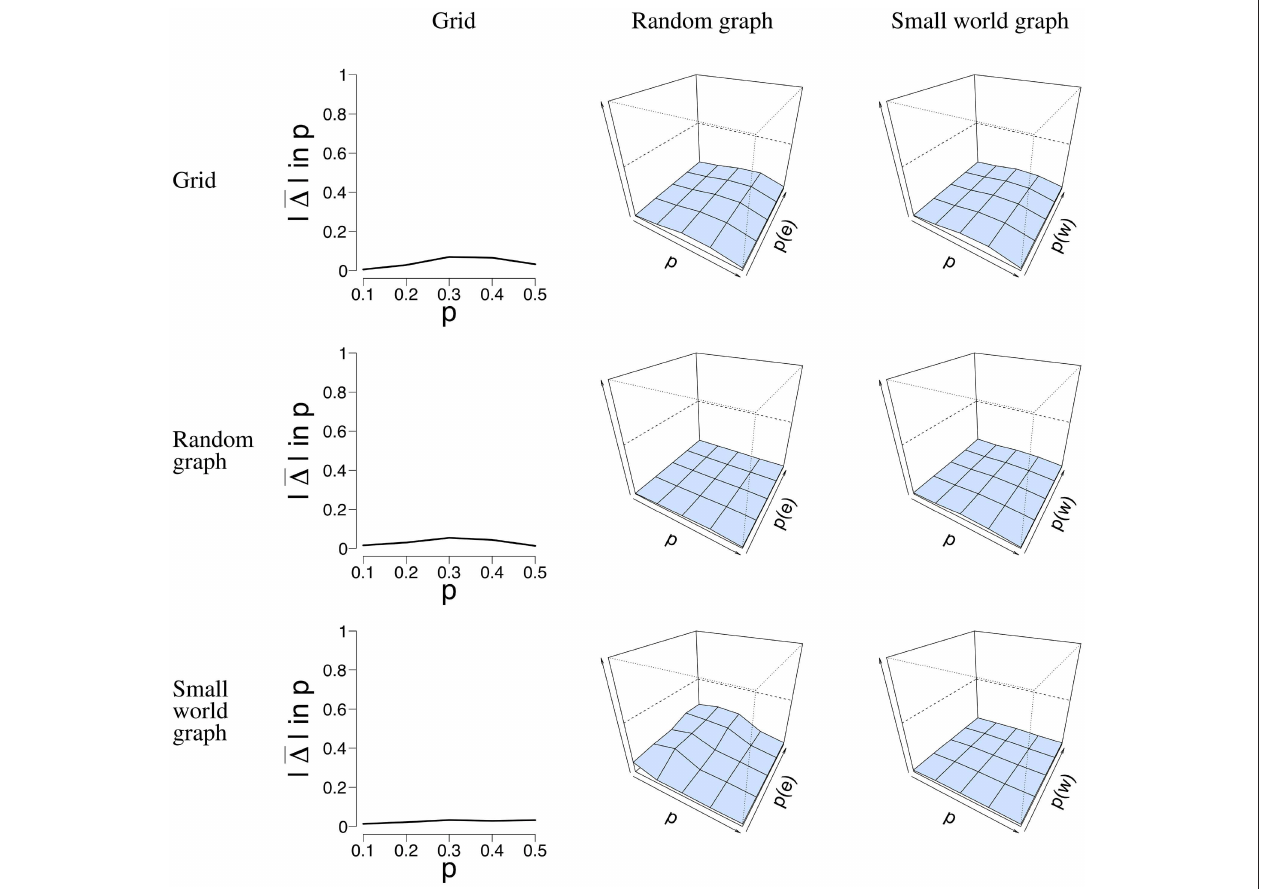
FIGURE 7 | Visualization of the mean absolute differences between p and ˆ p that resulted from the misspecification analysis with n = 100 nodes and T = 50 time points. The rows denote the structure for which the data were simulated. The columns denote the structure for which ˆ p was estimated, and the y -axis the mean absolute difference between p and ˆ p . For the middle and right column, the x -axis denotes the parameter p for which we simulated data, the z -axis the graph parameter that was used to simulate data, and the y -axis the mean absolute difference between p and ˆ p that ranges between 0 and 1. The mean absolute difference ranges between 0 and 1, where a lower value indicates a smaller difference between p and ˆ p